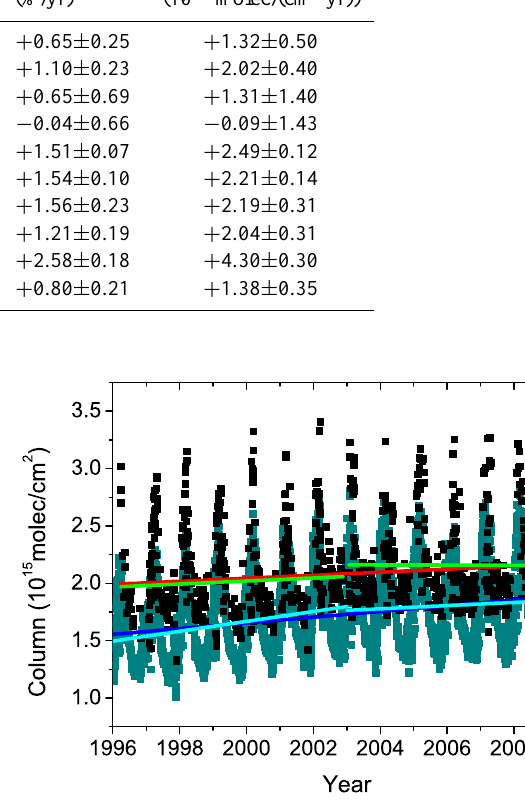
Fig. 2. Time series of FTIR measurements (black squares) and KASIMA model data (dark cyan squares) of HF above Kiruna from March 1996 to November 2009 and January 1996 to December 2009, respectively. The red and dark blue lines represent the lin- ear portion of the least squares fit of Eq. (1) to the measurements and model results, respectively, from 1996 to 2009. The green and cyan lines show the fits to the FTIR and KASIMA data, respectively, from 1996 to 2002 and 2003 to